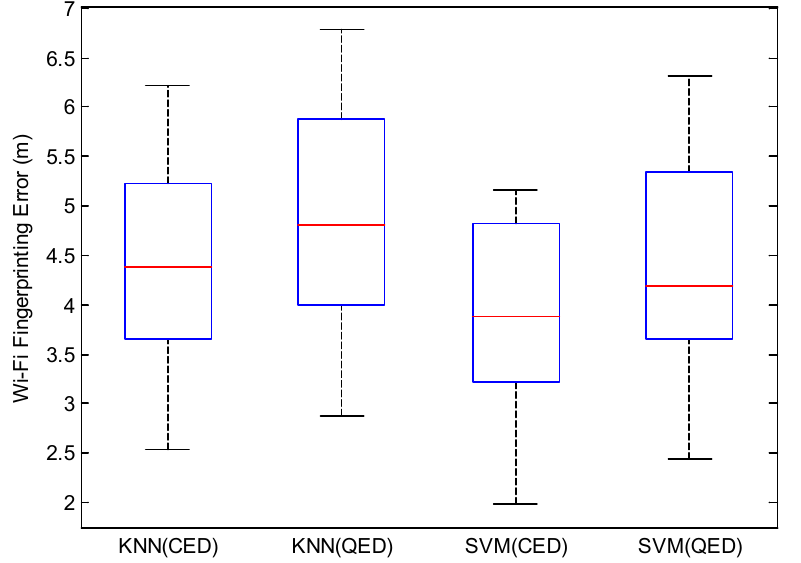
Figure 13. Accuracy comparison of CED and QED.